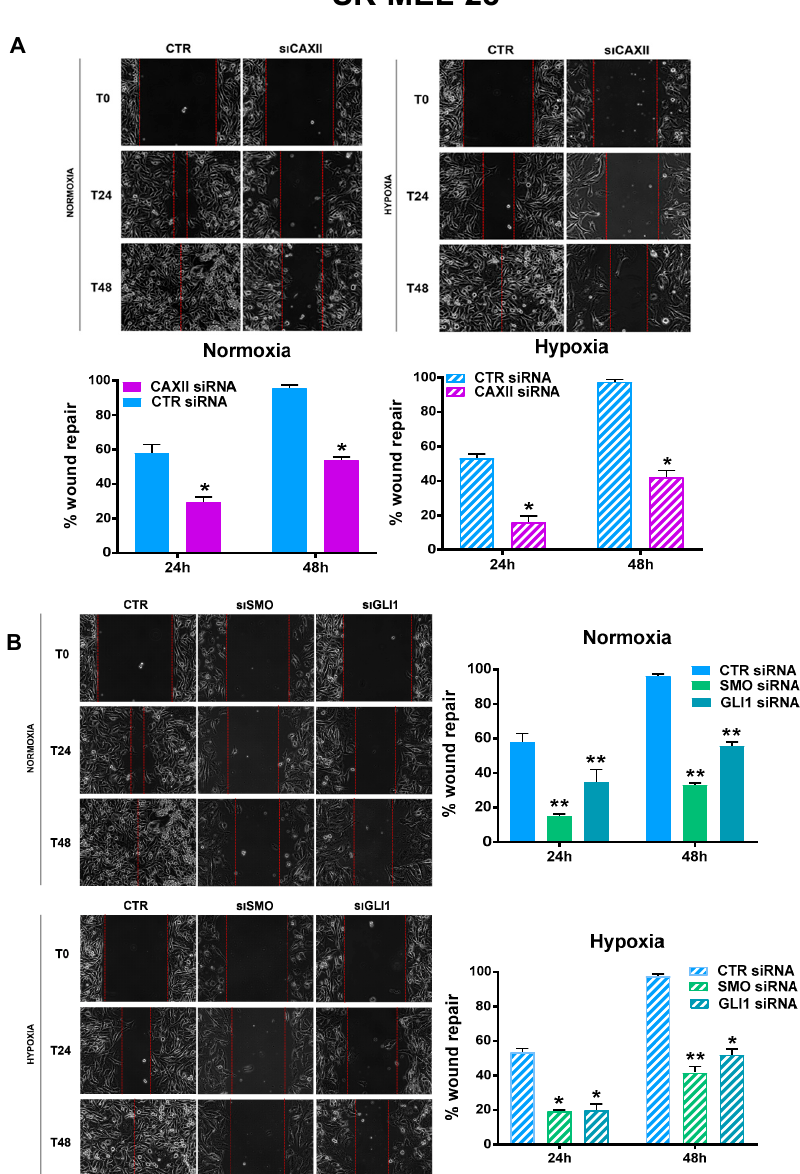
Figure 5. SK-MEL-28 cell migration was impaired by CAXII, SMO, and GLI1 transient knockdown. Cell migration measured by wound-healing assays under normoxic or hypoxic conditions in SK-MEL-28 cells silenced with CAXII ( A ), SMO, and GLI1 ( B ). Pictures are representative of three independent experiments. Means ± SEM are presented. (n = 3; * p ≤ 0.05 and ** p ≤ 0.01 indicate statistically significant